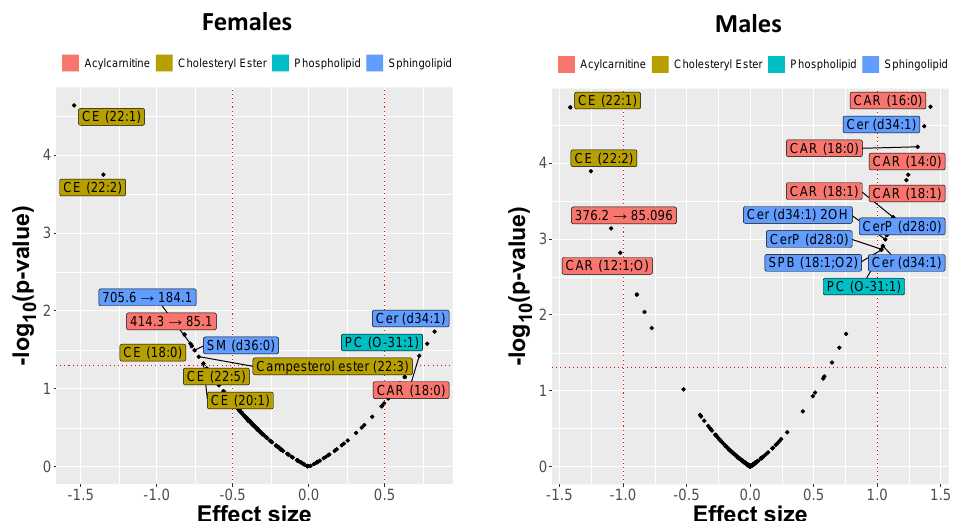
Figure 2. Effect size of changes in lipid abundances in the skin of atopic dogs at baseline vs. healthy controls separated by sex. The effect sizes are represented as standardized mean difference (SMD or Cohen’s d ).